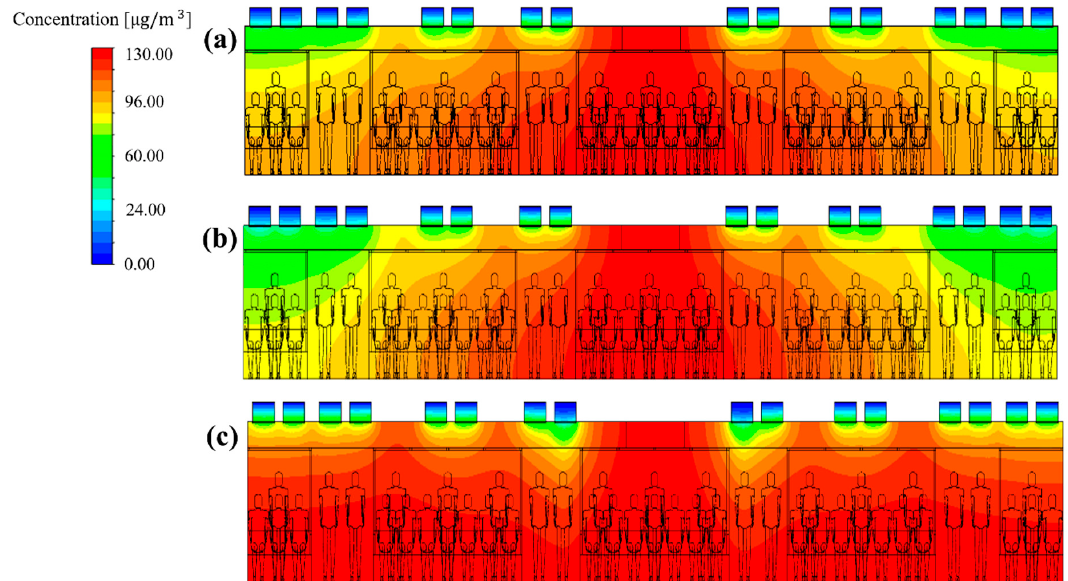
Figure 10. PM 10 concentration distribution in the central section of the cabin according to the selected flow rate ratios (a total ventilation flow rate of 500 CMH and filter efficiency of 70% applied). ( a ) Case 1; ( b ) case 5 and ( c ) case 23.